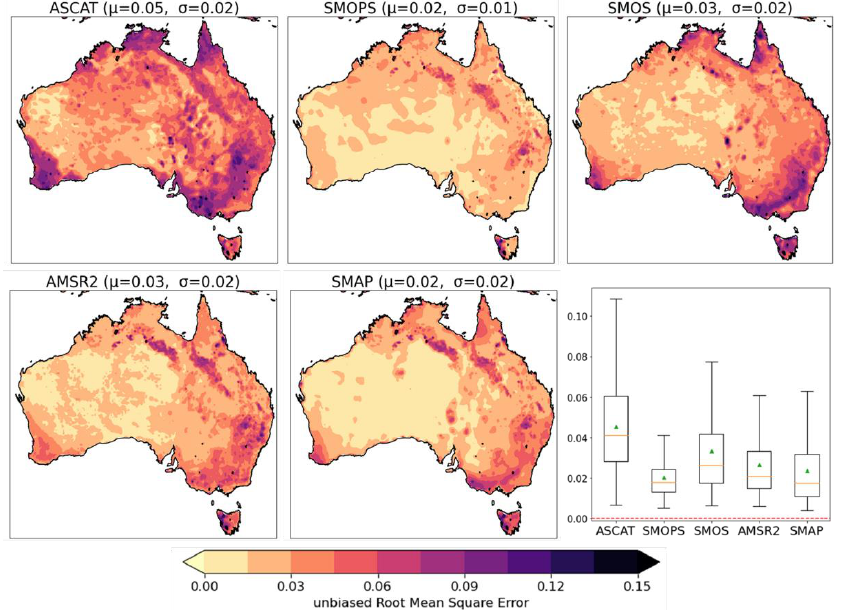
Figure 9. Temporal ubRMSE results depicted spatially for ASCAT, SMOPS, SMOS, AMSR-2, and SMAP. An accompanying box-whisker plot depicts the spatio-temporal results — whiskers extend out to show the interquartile range, the orange line indicates the distribution median, and the green triangle indicates the distribution mean, red dashed line indicates perfect value. Figure 10 depicts the results of the correlation between AWRA-L and the satellite SM datasets. Here only spatial plots of ASCAT, SMOPS, and SMOS are depicted as time series correlations between AMSR-2/SMAP and AWRA were insignificant. Furthermore, any grid cells that have insignificant correlations are masked. Despite SMOS having the higher correlation coefficient across Australia on average, we note that its performance along Australia ’ s southeast coast is considerably lower than ASCAT and even insignifi- cant (masked) in several regions. Figure 10. Temporal correlation coefficient results depicted spatially for ASCAT, SMOPS, SMOS, AMSR-2, and SMAP. An accompanying box-whisker plot depicts the spatio-temporal re-